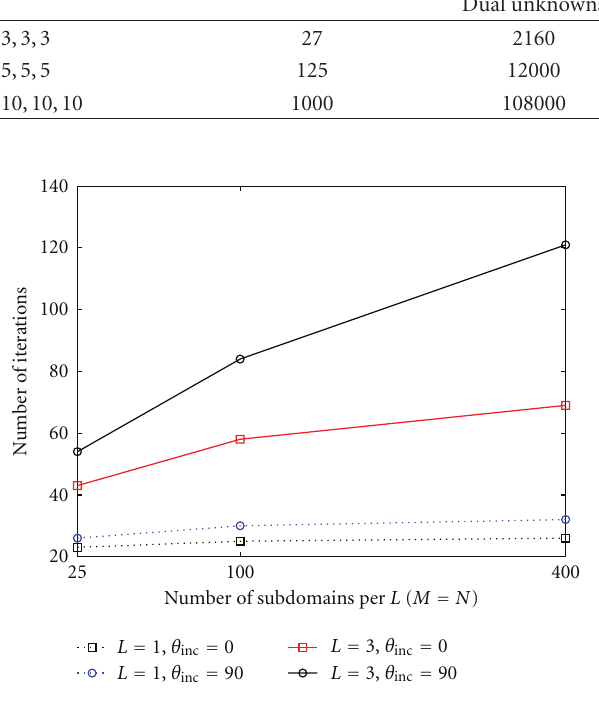
Figure 4: Iteration number versus number of subdomains for di ff erent L .